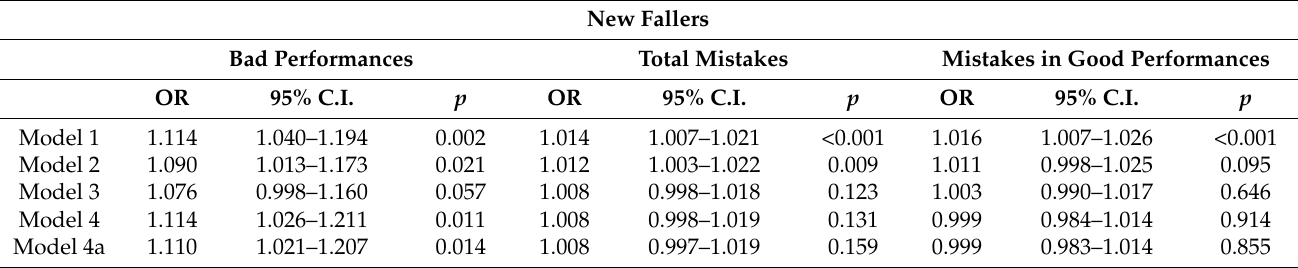
Table 3. Comparison of the OR and corresponding 95% C.I. of bad performances , total mistakes, and mistakes in good performances for the prediction of new fallers in the binary logistic regression